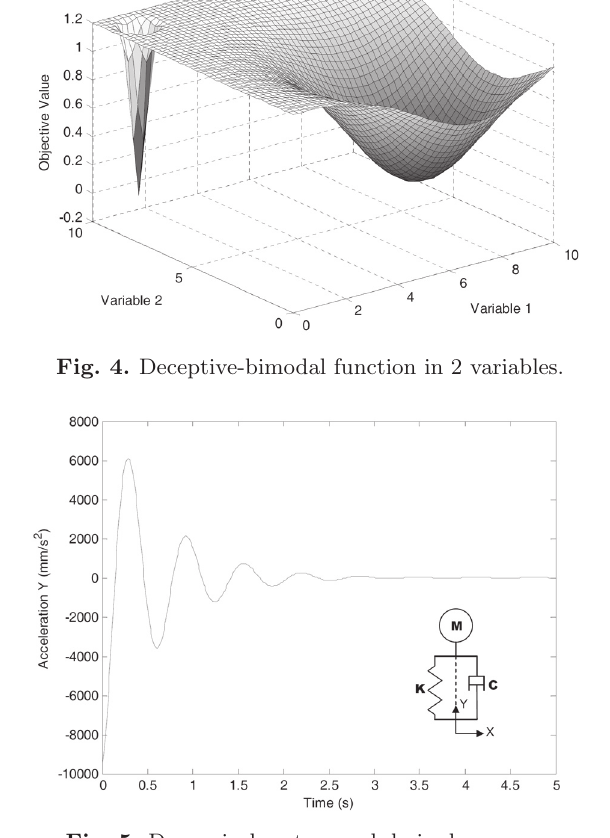
Fig. 5. Dynamical system and desired